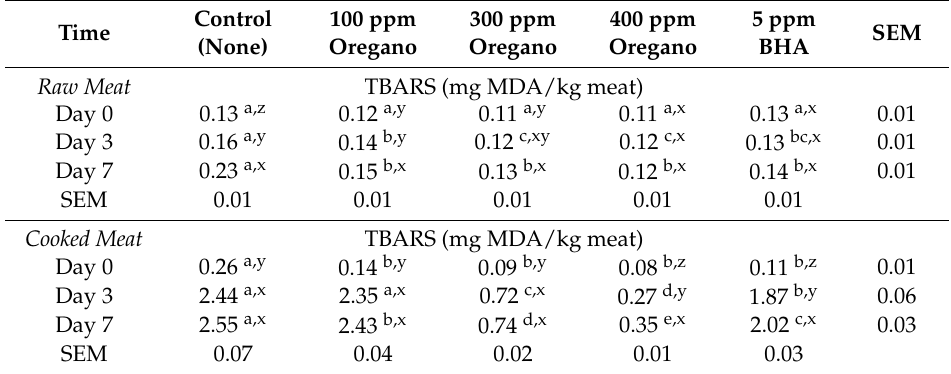
Table 1. 2-Thiobarbituric acid-reactive substances (TBARS) values of raw and cooked chicken breast meat with different levels of oregano oil during